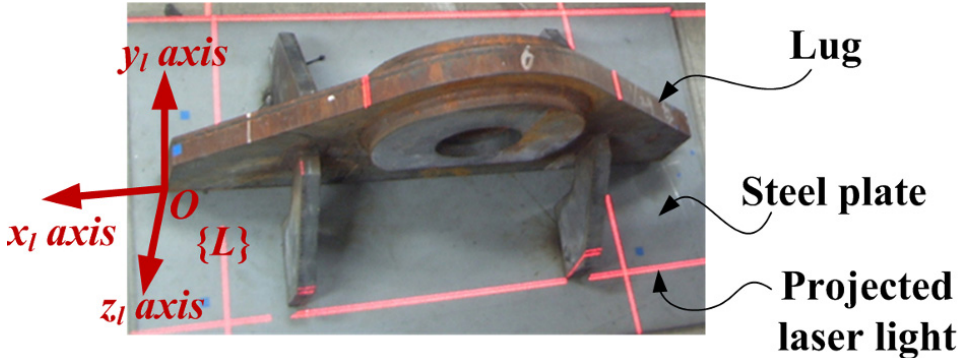
Figure 8. Top view image with the lug frame { L }.